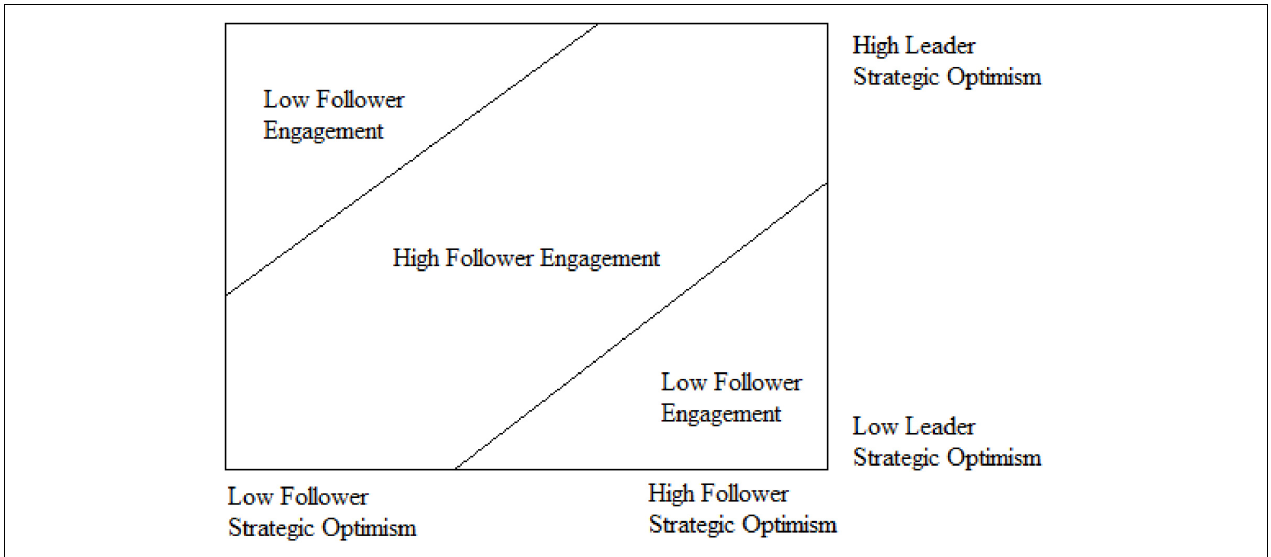
FIGURE 1 | Follower engagement (mis)match